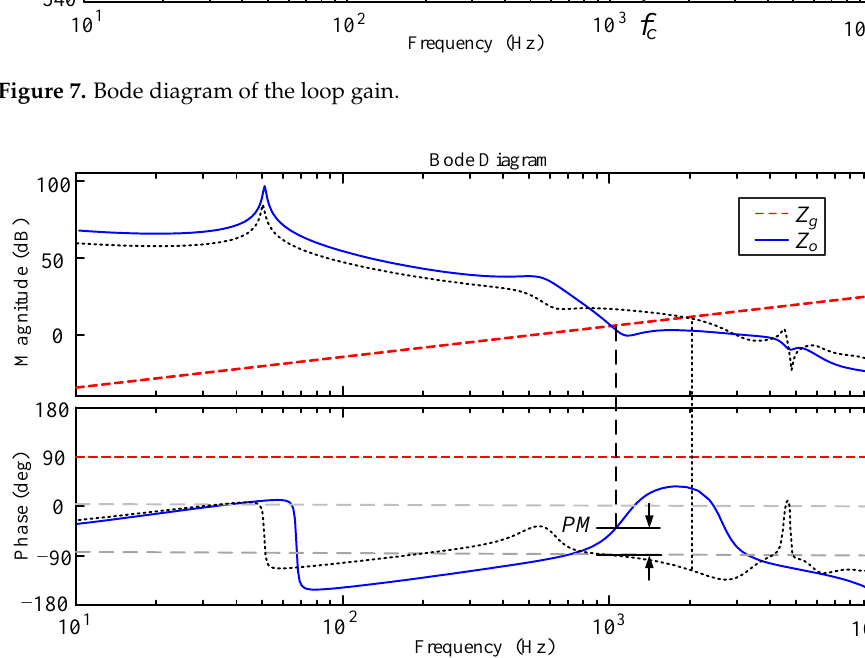
Figure 8. Bode diagram of Z g and Z o .